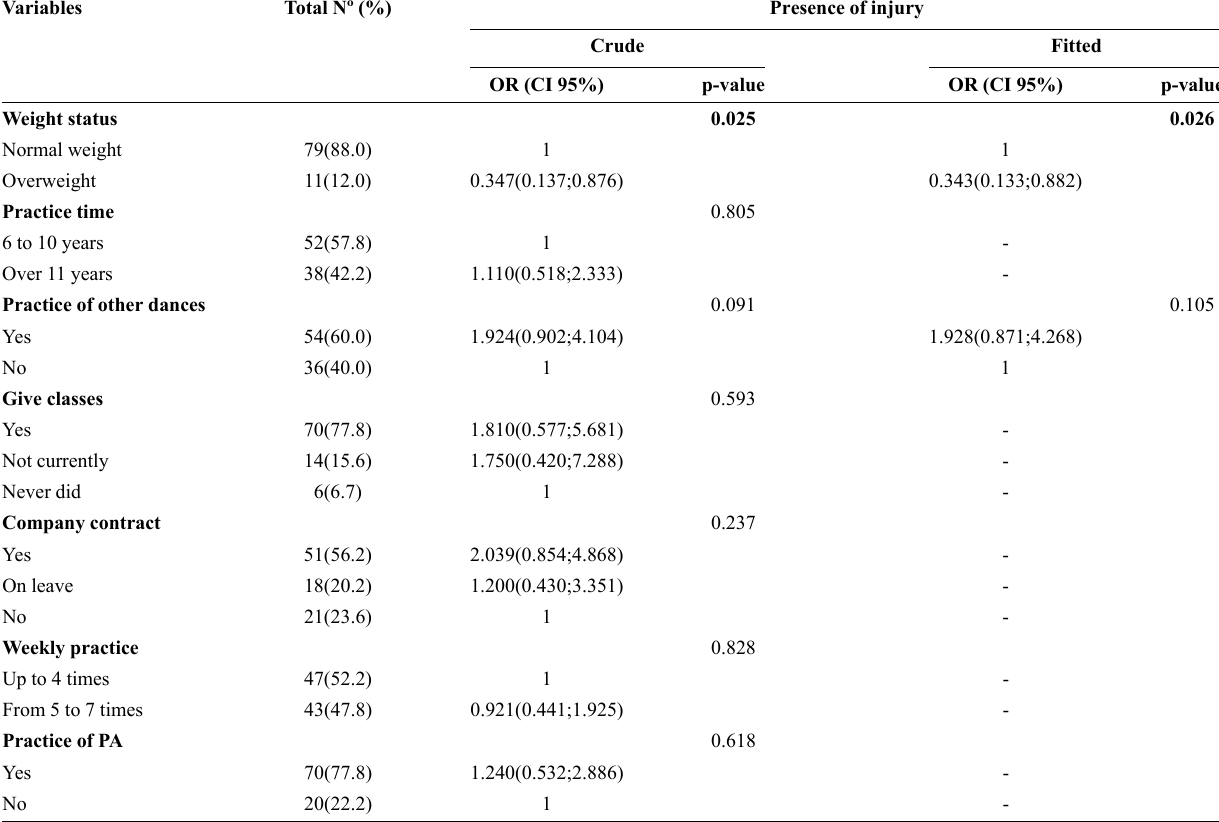
Table 3 - Crude and fitted chance ratios and prevalence of associated factors for the presence of injuries in professional female ballroom dancers, Brazil, 2015-2016 (n=